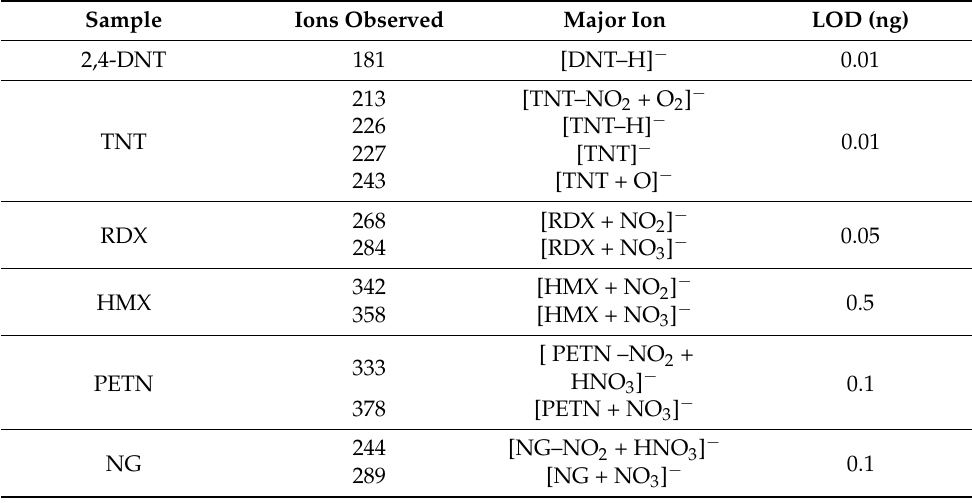
9 Figure 8. Dynamic range and linearity, in case of TNT. Table 2. Characteristic product ion and LOD of six tested